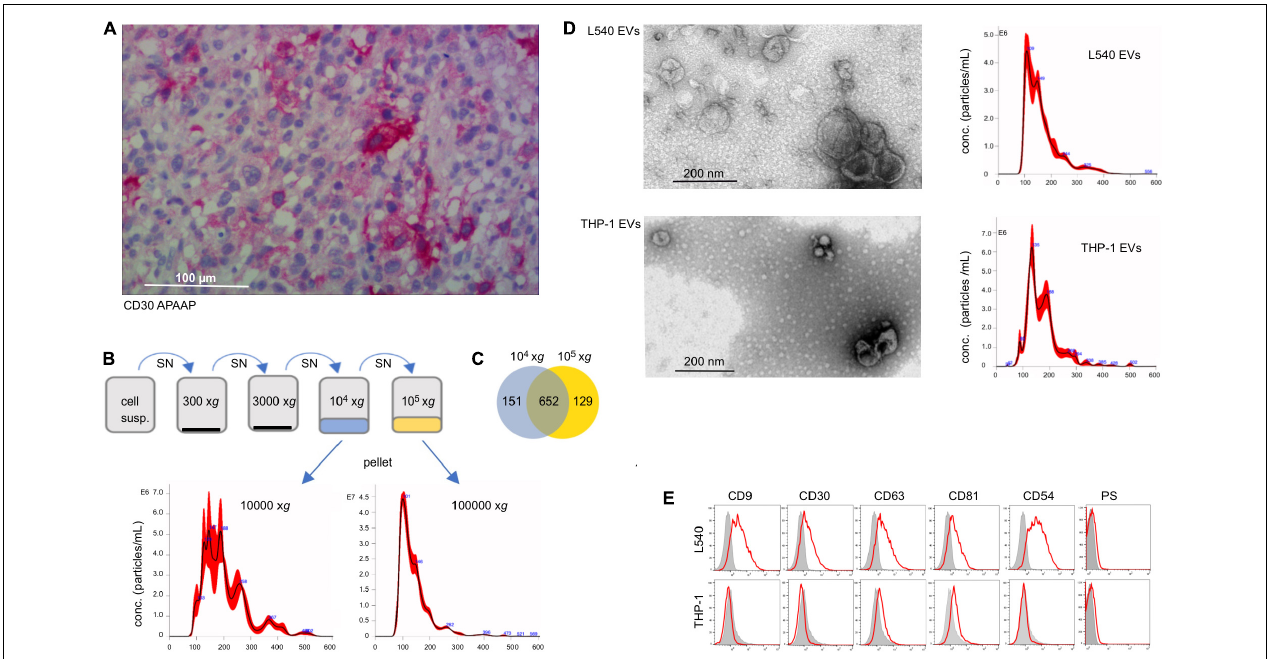
FIGURE 1 | Characterization of CD30 + EVs. (A) Tissue section of lymph node infiltrated with DLBCL cells, which was stained with CD30 mAb (Ber-H2). The bar indicates 100 µ m. (B) Characterization of EVs from the cell supernatant of L540 cells. They were isolated by a series of centrifugation steps. The 10,000 × g and the subsequent 100,000 × g fraction were studied by NTA and mass spectrometry. (C) The common and individual mass spectrum hits are shown in a Venn diagram. (D) The pooled 10,000 × g and 100,000 × g EV fractions of L540 and THP-1 supernatants were studied by transmission electron microscopy. The diameter (x-axis) and count (y-axis) of the EVs from the cell supernatant of L540 and THP-1 cells were analyzed by NTA. (E) The EVs were bound to 10 µ m microspheres and analyzed by flow cytometry. The EVs were stained for CD9, CD30, CD63, CD81, CD54, and phosphatidylserine (red) and compared to the isotype controls